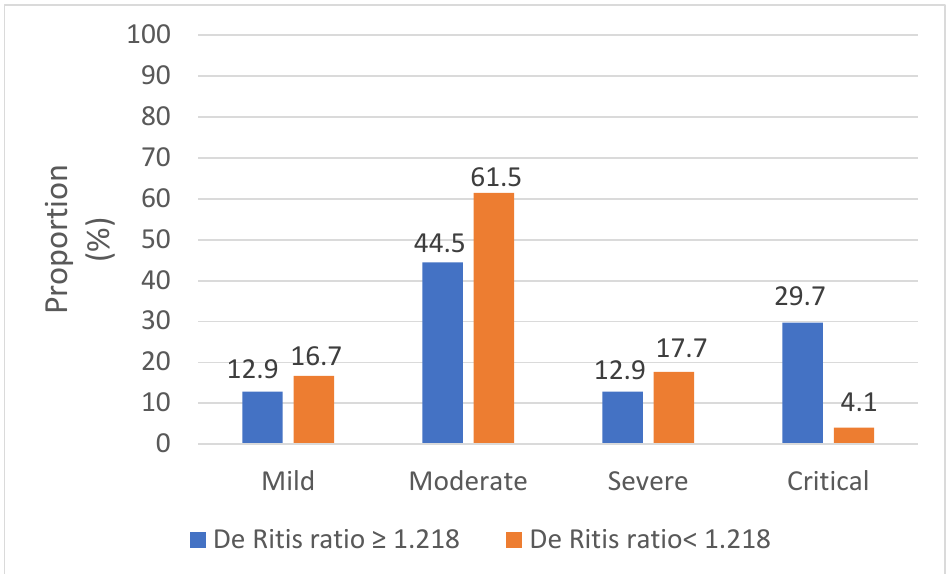
Figure 5. Association between De Ritis ratio and disease severity grade in COVID-19 patients.